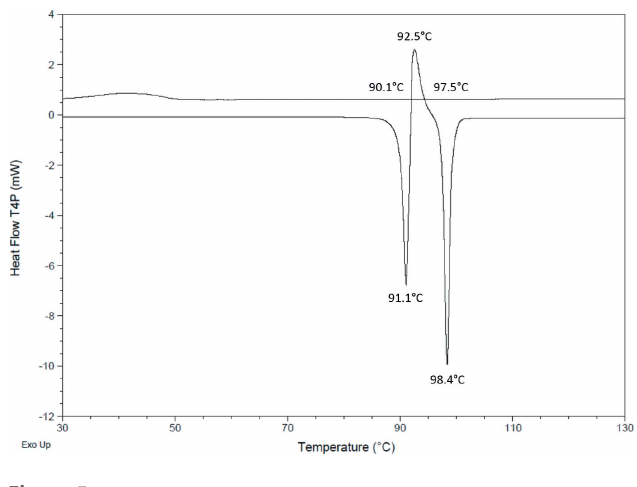
Figure 5 Differential scanning calorimetry thermogram of form